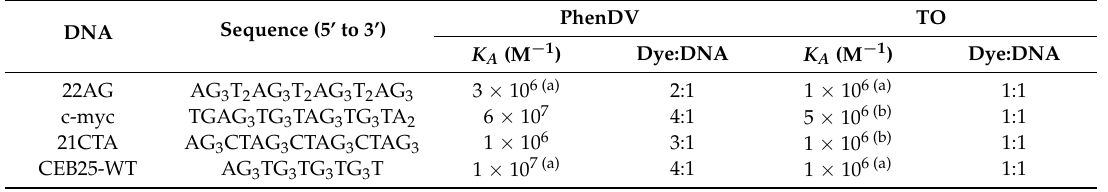
Table 1. The PhenDV and TO affinity constants measured in the presence of 22AG, c-myc, 21CTA, and CEB25-WT G4